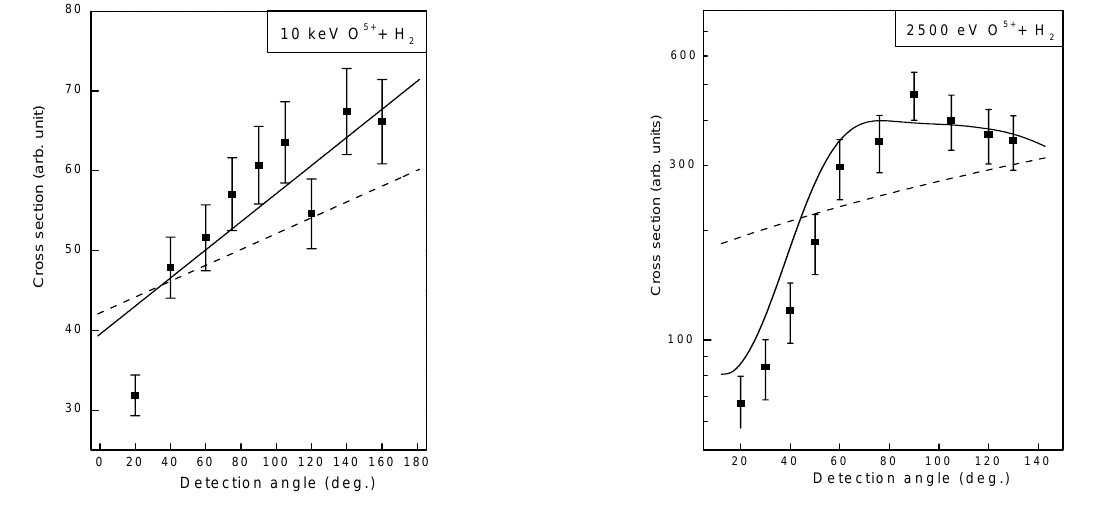
Figure 10. Differential cross section for detecting one fragment in 75 keV and 2.5 keV O collisions. Full squares, experimental values; dashes curves, TS2B calculations; solid curves, OS3B